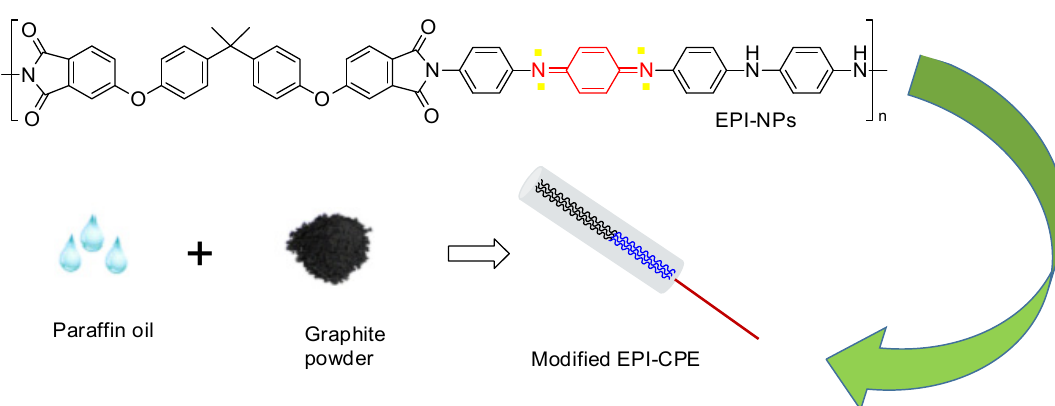
Figure 1. The flowchart for preparing CPE modified with different samples (i.e., EPI-S, EPI-P, and EPI-G).